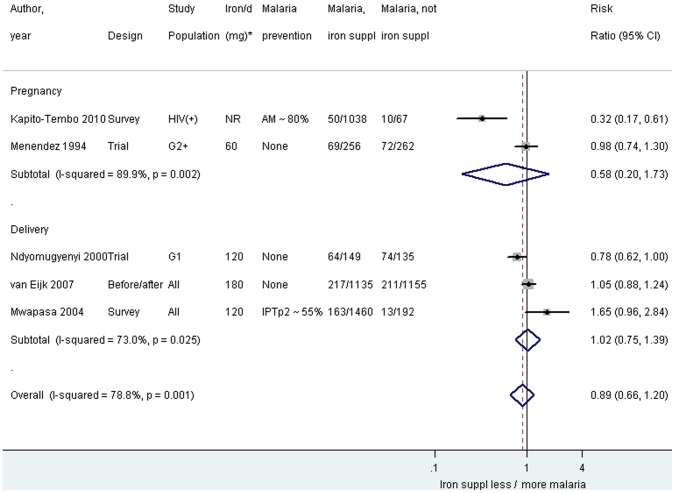

Plasmodium falciparum by blood smear among iron-supplemented and non-supplemented pregnant women by timing of malaria test.Footnote: AM: antimalarials used (either IPTp or cotrimoxazole). CI: confidence interval. G1: primigravidae. G2+: Multigravidae. HIV(+): HIV-positive. IPTp2: intermittent preventive treatment with 2 doses of sulfadoxine-pyrimethamine. *Daily dose of elementary iron. Notes: At delivery: placental blood smear for Ndyomugyenyi 2000 and van Eijk 2007, and peripheral blood smear for Mwapasa 2004. The weight for each study is indicated as a grey block around the risk estimate. Subgroup analyses and additional data are included in eSupplement 3.